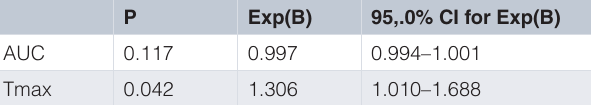
Table 8. Cox regression.